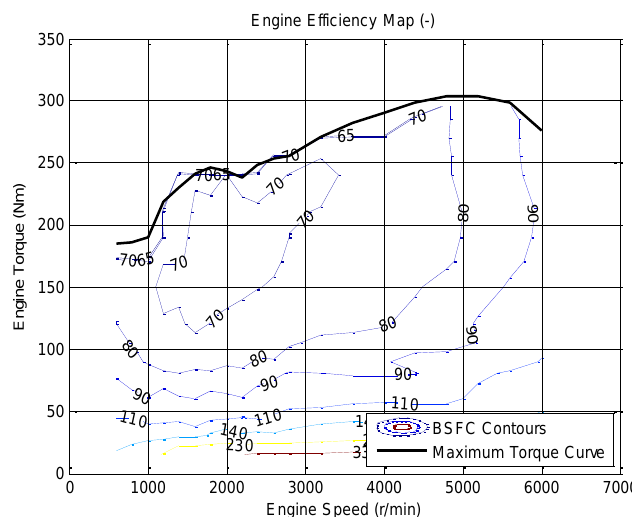
Figure 5. Internal combustion engine’s e ffi ciency chart.